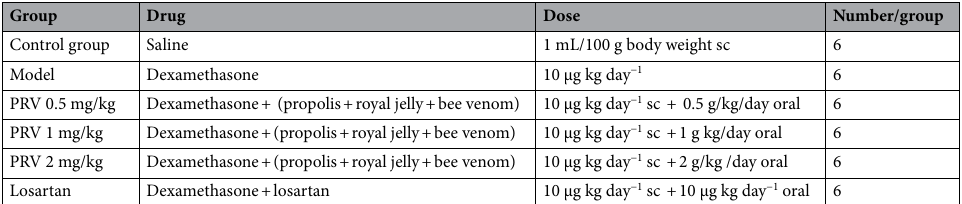
Table 5. The treatment of experimental animal groups. PRV propolis, royal jelly & bee venom, sc subcutaneously.